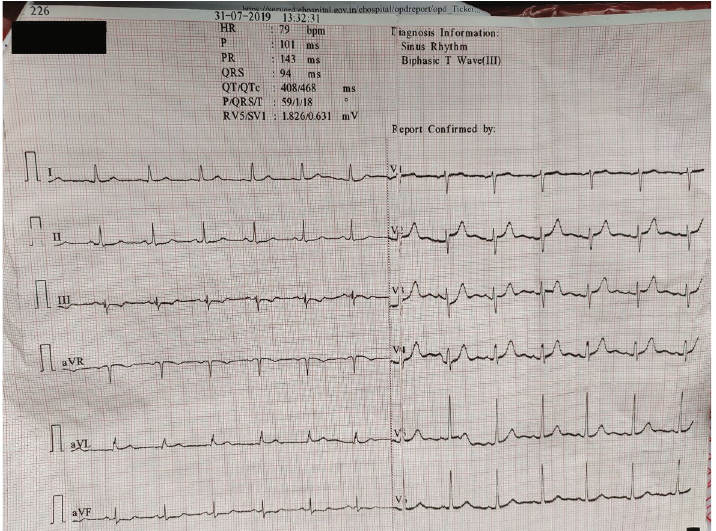
Figure 2: Electrocardiogram revealed a sinus rhythm with biphasic T wave in lead III and a QTc of 468